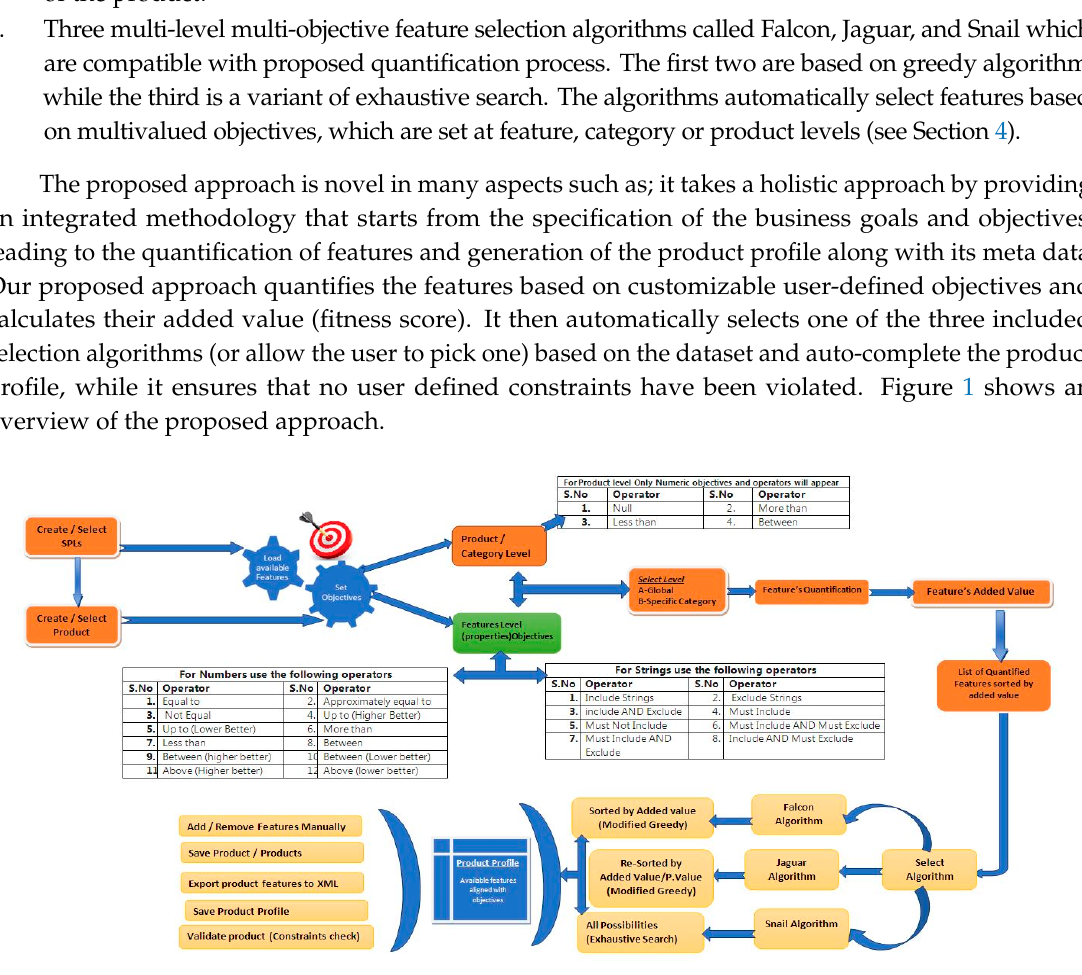
Figure 1. The Solution Architecture. SPLs: Software Product Lines.